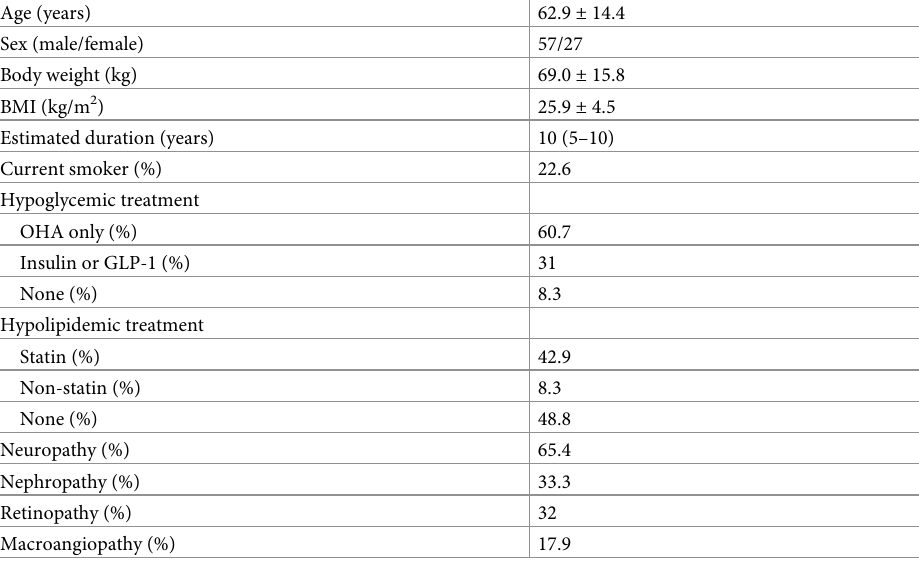
Table 1. Baseline